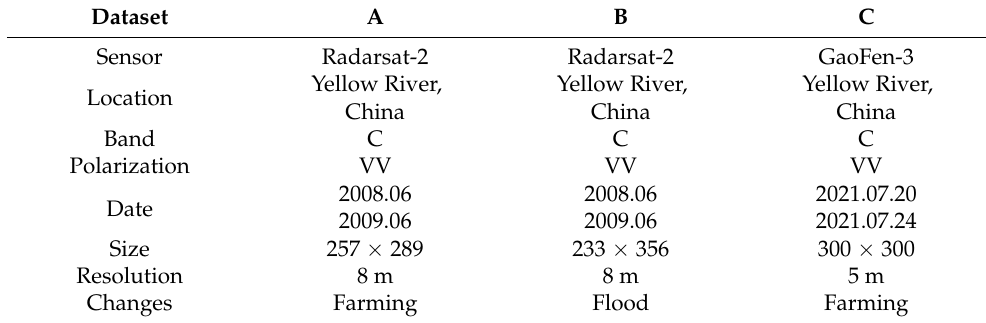
Table 2. Details of a real SAR data